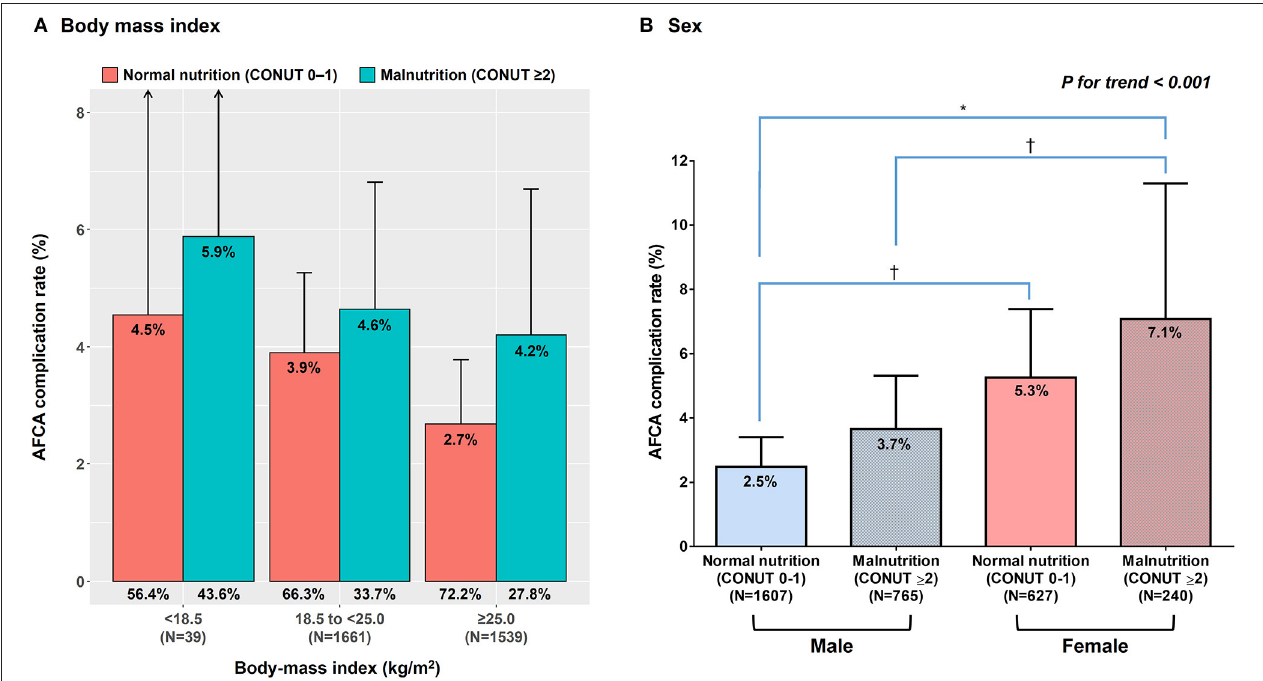
FIGURE 2 | Effects of nutritional status on rates of the overall complications according to body mass index (A) and sex (B). *Indicates P < 0.001 between the two groups. † Indicates P < 0.05 between the two groups. AFCA, atrial fibrillation catheter